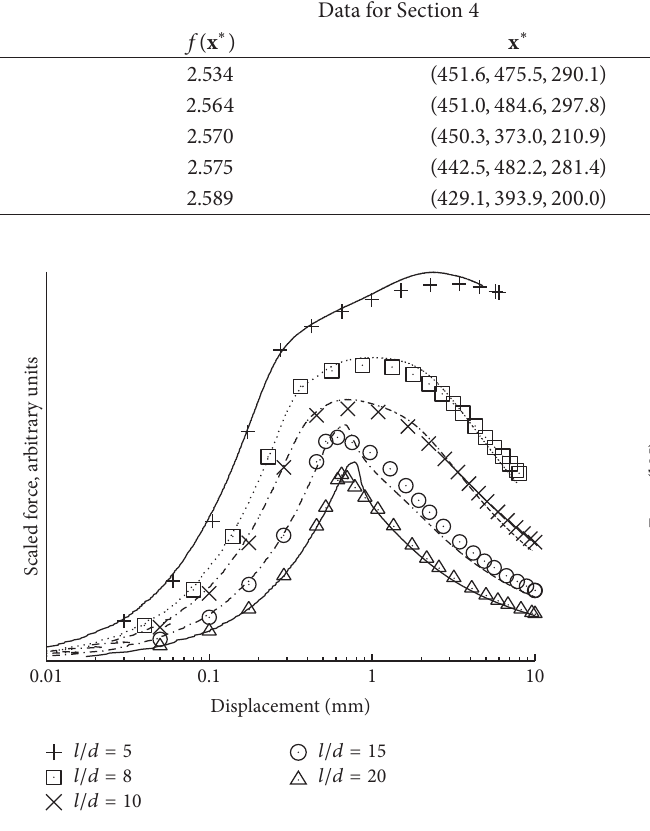
Figure 8: FE load-displacement traces obtained with the best estimate of the global minimum using only the buckling data, 𝜎 0 = 451.6 MPa, 𝑘 = 475.5 MPa, 𝑛 = 0.2901 , and 𝑓( x ∗ ) = 2.534 , are shown as symbols. Superimposed lines show the experimental data. Note that the curves are deliberately separated for clarity, via arbitrary scaling of the load for each dataset. The plot is used exclusively to highlight a match between the FE and the experiment for each geometry.